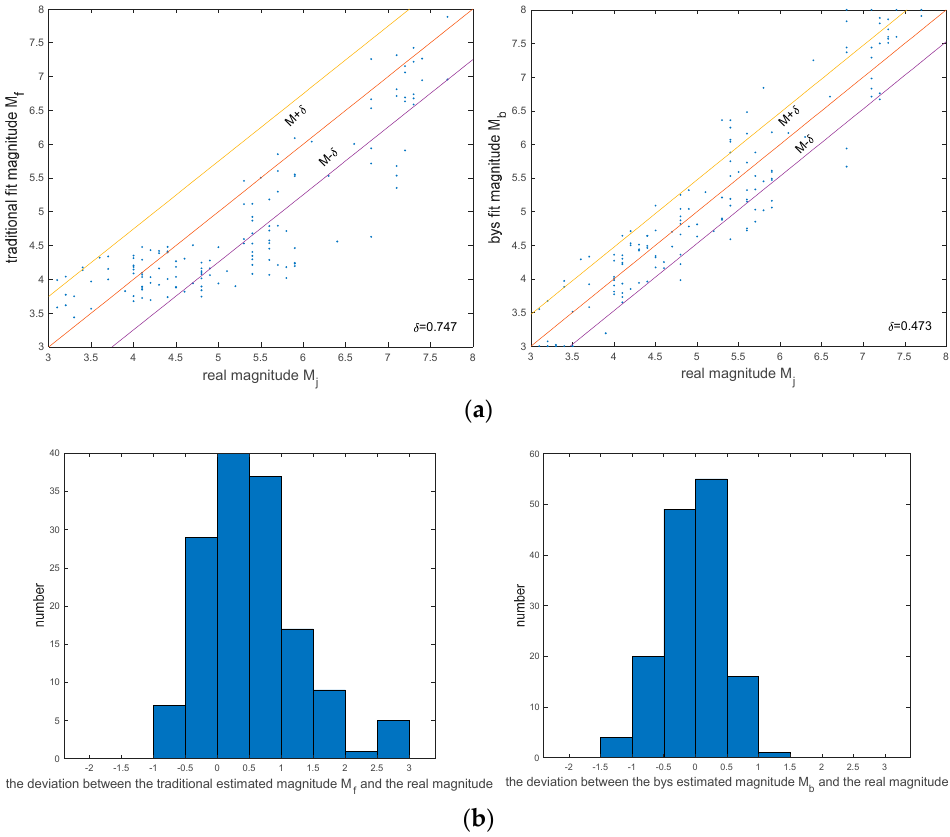
Figure 5. Comparison of the actual magnitude and the predicted magnitude using the conventional method and the Bayesian inference method ( a ) and its error distribution ( b ).